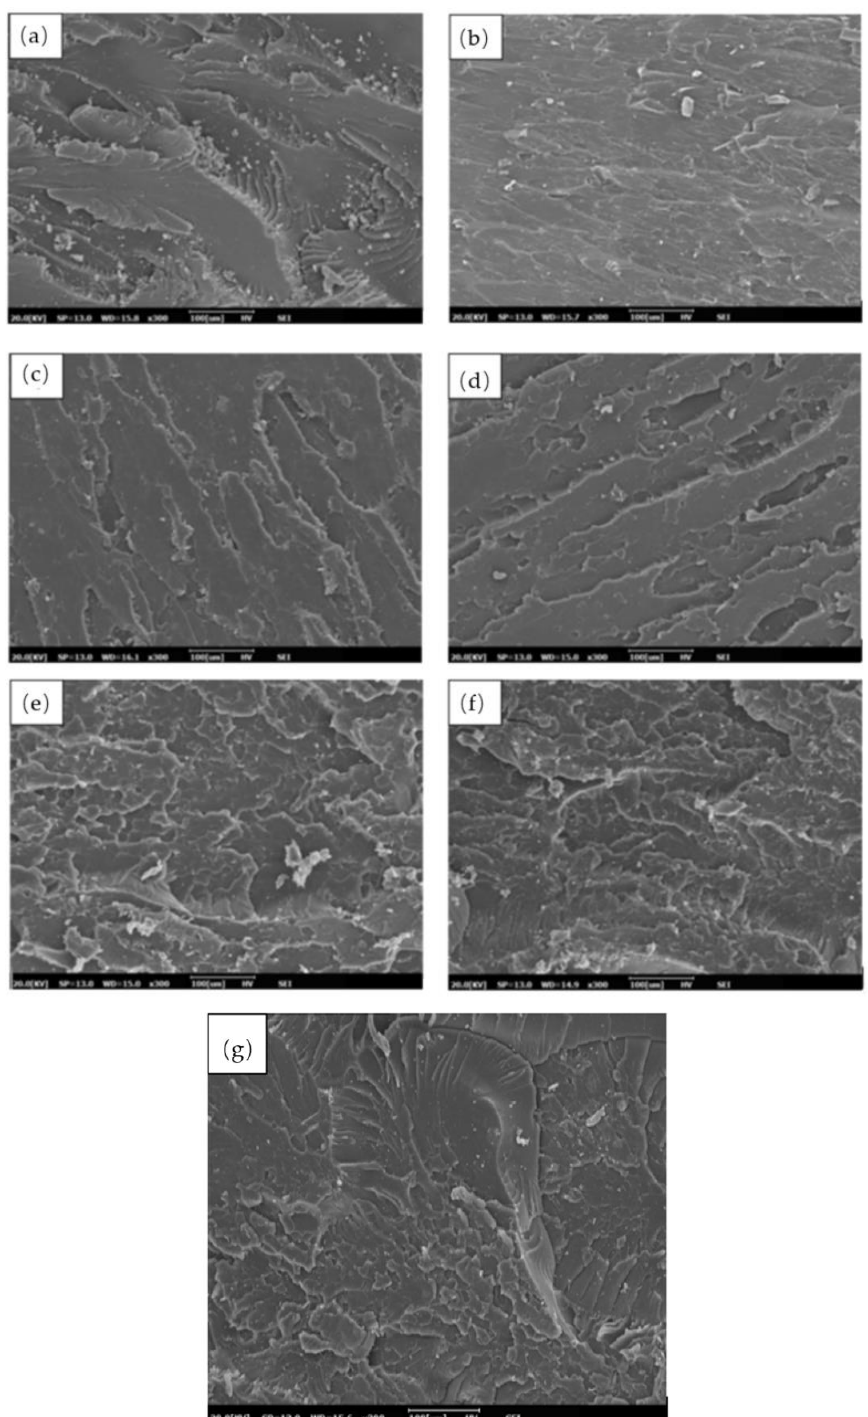
Figure 4. SEM of tensile fractured: ( a ) epoxy ( b ) bio-phenolic ( c ) P-5 ( d ) P-10 ( e ) P-15 ( f ) P-20 ( g )